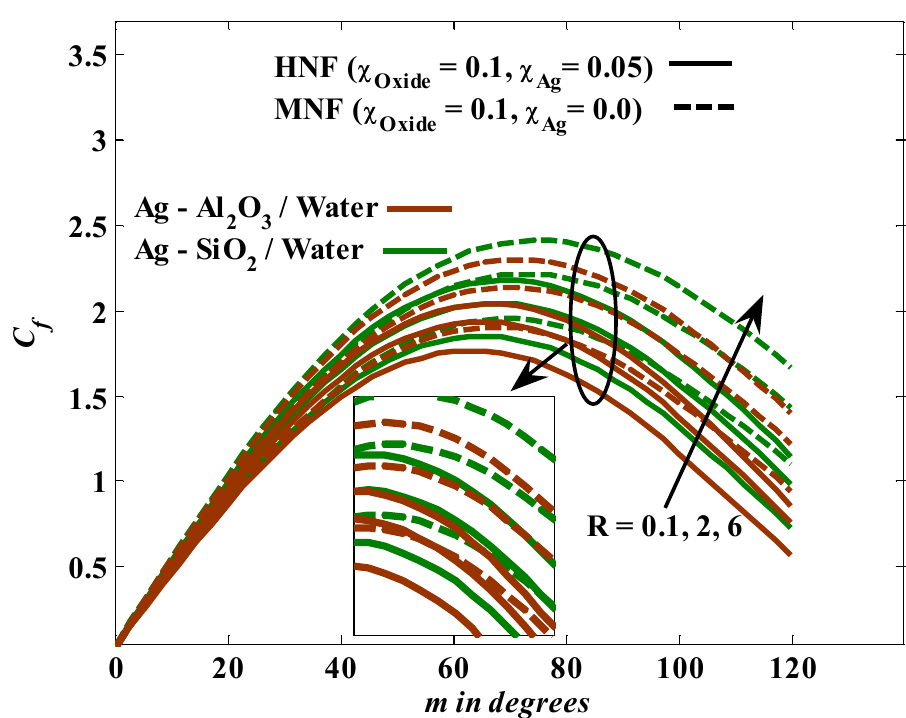
Figure 5. Illustration of R versus skin friction at fixed values of We = 0.2, λ = 0.1, & M = 1.